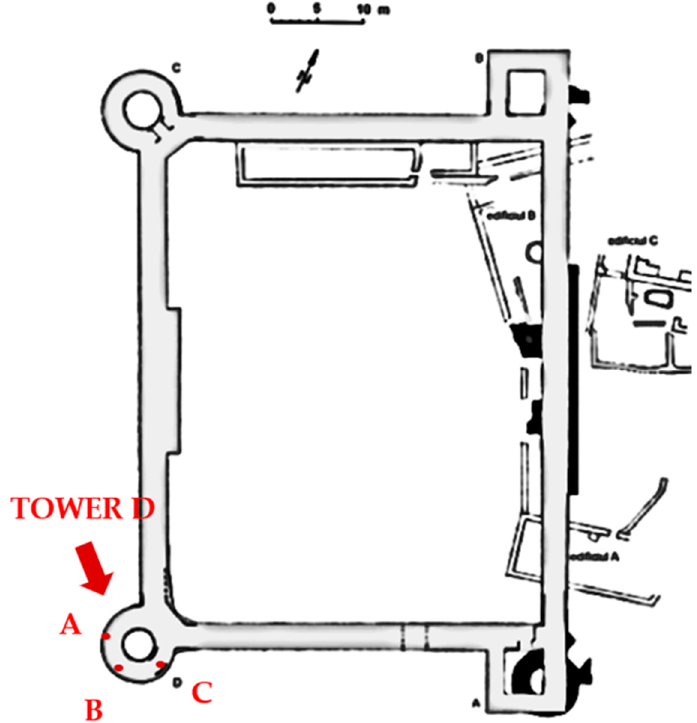
Figure 2. Sketch of the fortress from Ovidiu and location of the samples A, B, and